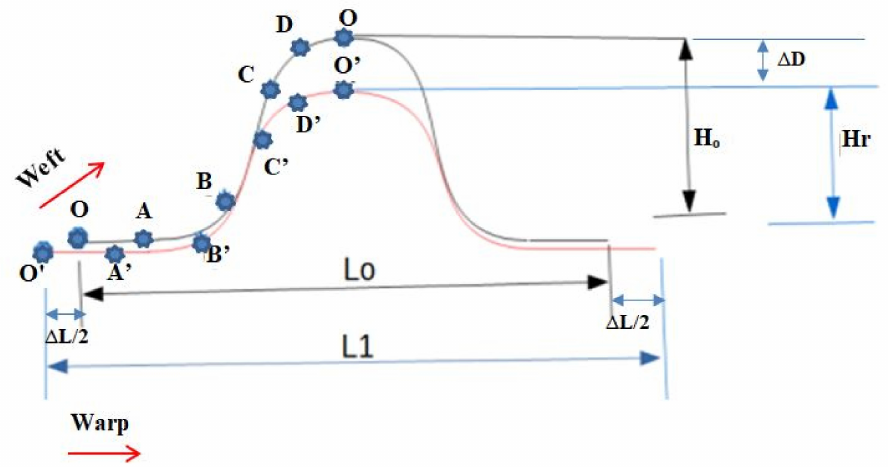
Figure 14. Schematic diagrams of preform in front view at maximum deformation (Ho) and after recovery